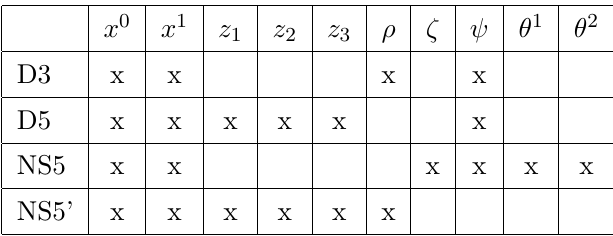
) span the T 3 , 1 , z 2 , z 3